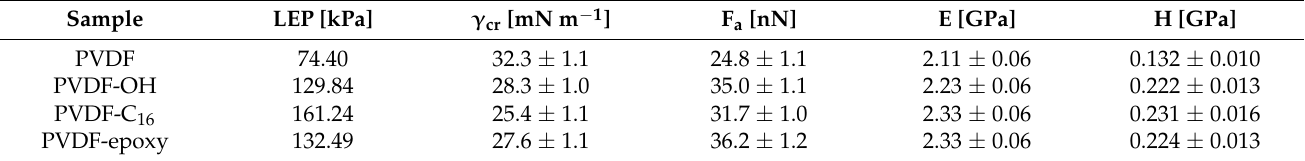
Table 2. Wetting (LEP, γ cr ) and mechanical (F a , E, H) features of the investigated